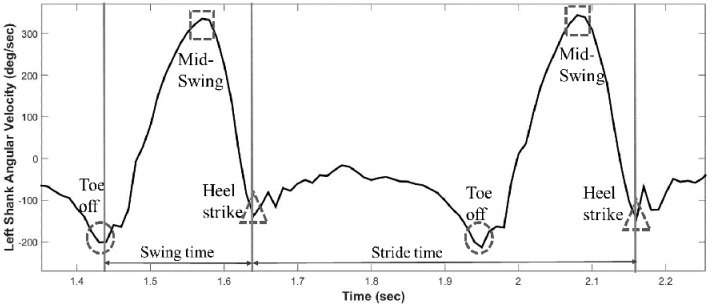
Schematic of shank angular velocity and gait events.